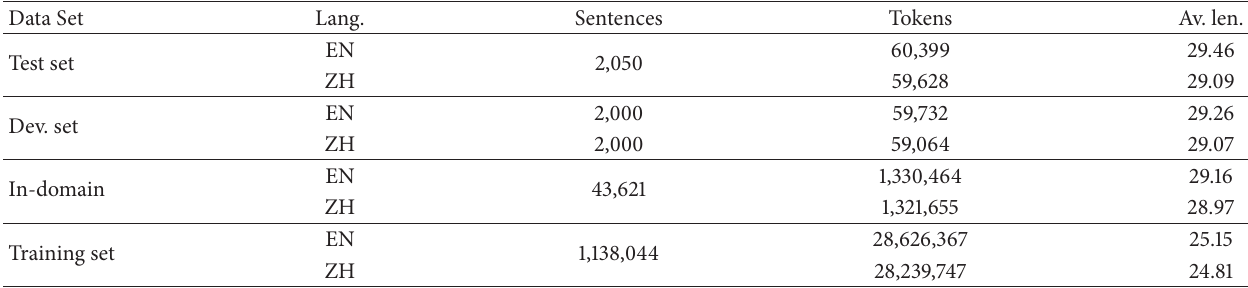
Table 2: Corpora statistics.